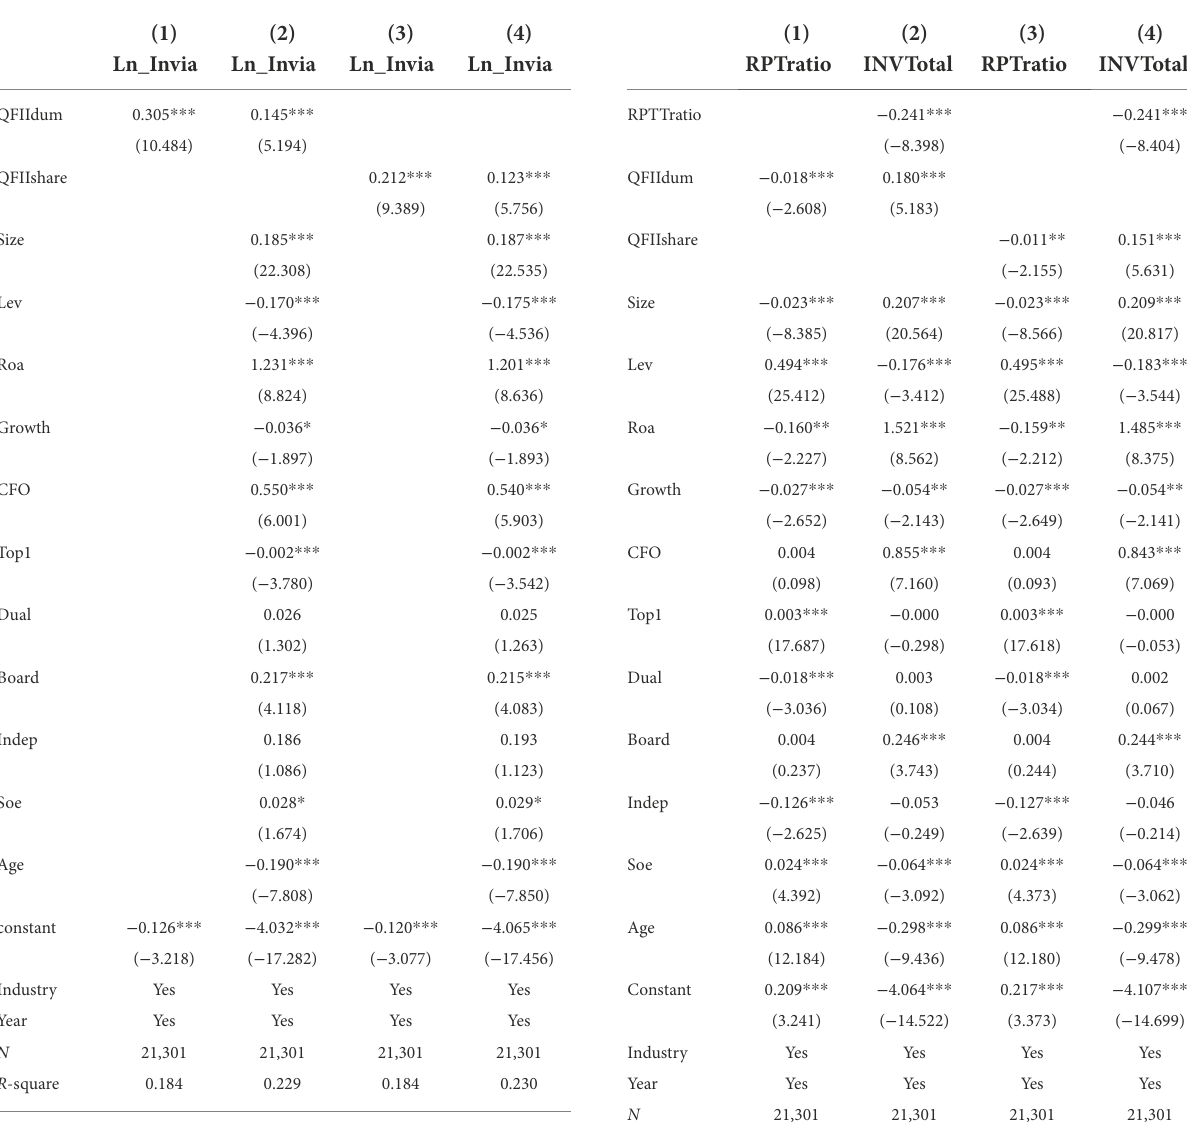
TABLE 4 Qualified Foreign Institutional Investors (QFII) and the quality of corporate innovation.